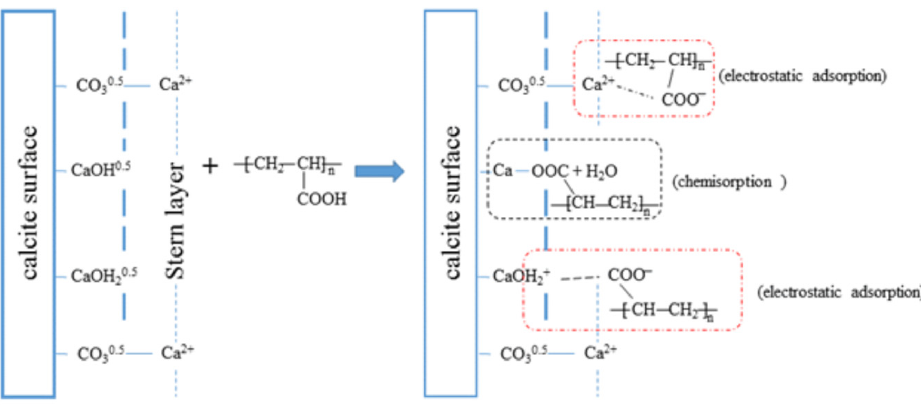
Figure 9. Proposed models for the adsorption of PAA on calcite surfaces.